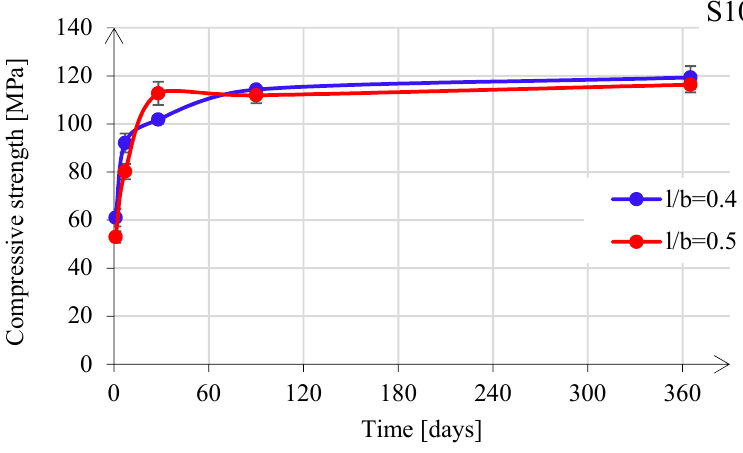
Figure 10. Compressive strength development for S100 paste. Table 3. Properties of gel phases in alkali-activated GBFS paste and OPC-based paste. Alkali-Activated GBFS, OPC Paste Property w/GBFS = 0.38